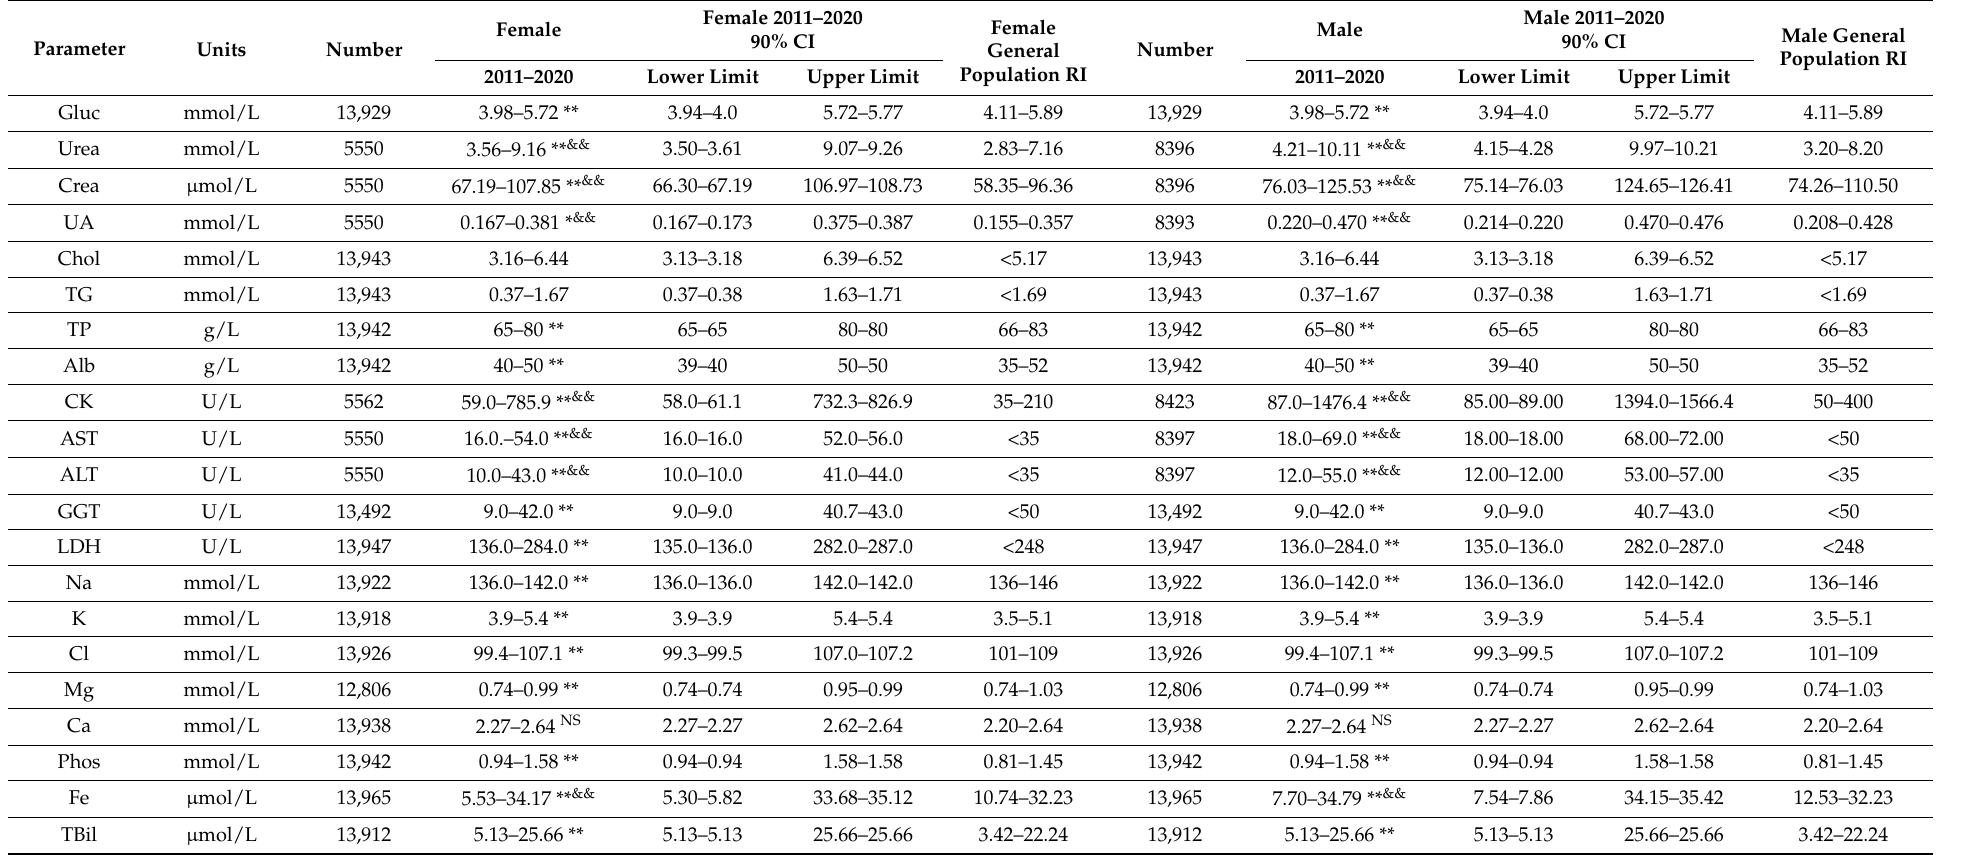
Table 1. Reference intervals (RIs) and basal values for biochemical